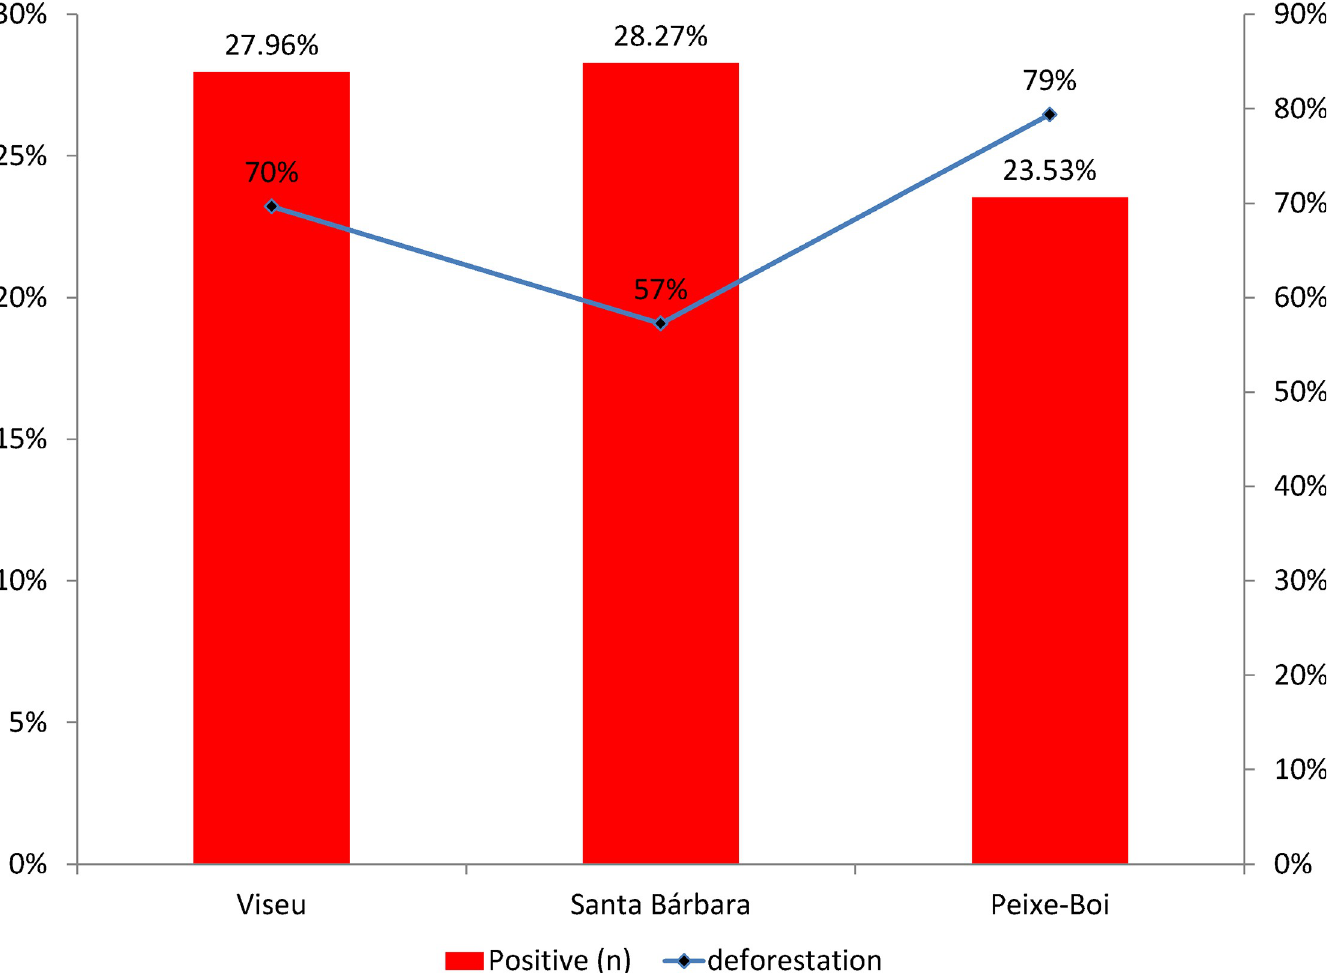
Fig 7. Positivity to RVA correlated with deforestation in the three cities of the Brazilian Amazon. Source: PRODES (http://www.dpi.inpe.br/prodesdigital/ prodesmunicipal.php).